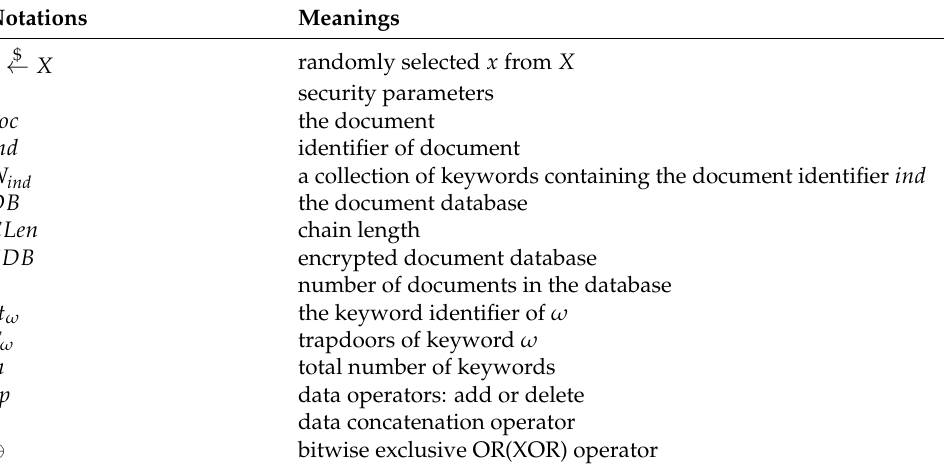
Table 1. Parameter